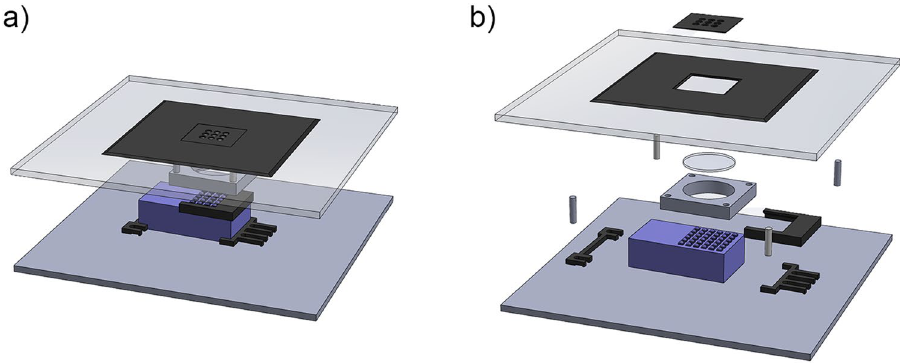
Figure 6. ( a ) The 3D model of the optical assembly. The 3D printed parts are colored dark grey. The LED array module is colored blue. The bottom plate is the optical breadboard. The top plate is the acrylic platform. The black masking tape covering the platform, the robot arms parts, and the optomechanical mount of the platform are not shown. ( b ) The exploded view of the assembly to show the individual